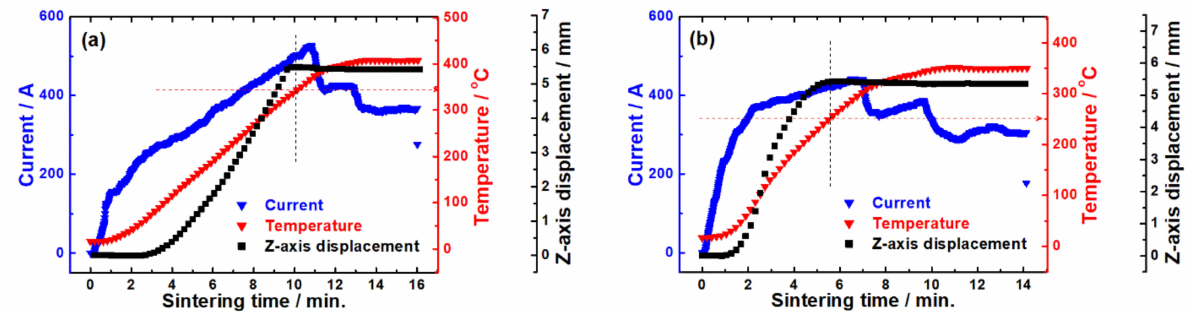
Figure 1. Variation in the Z -axis displacement of a graphite mold filled with ( a ) pristine Bi 2 Te 3 and ( b ) Bi 2 Te 3 –polypyrrole during the spark plasma sintering process at 400 and 350 ◦ C, respectively, accompanied by the control of the electric